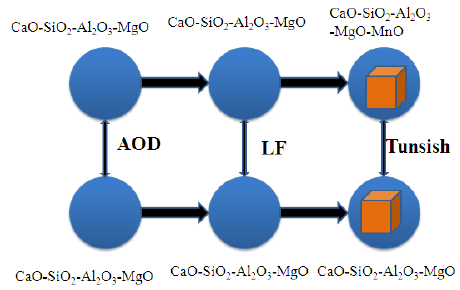
Figure 12. Schematic illustration of the formation mechanism of the inclusions containing spinel crystals during manufacturing of 304L stainless steel.